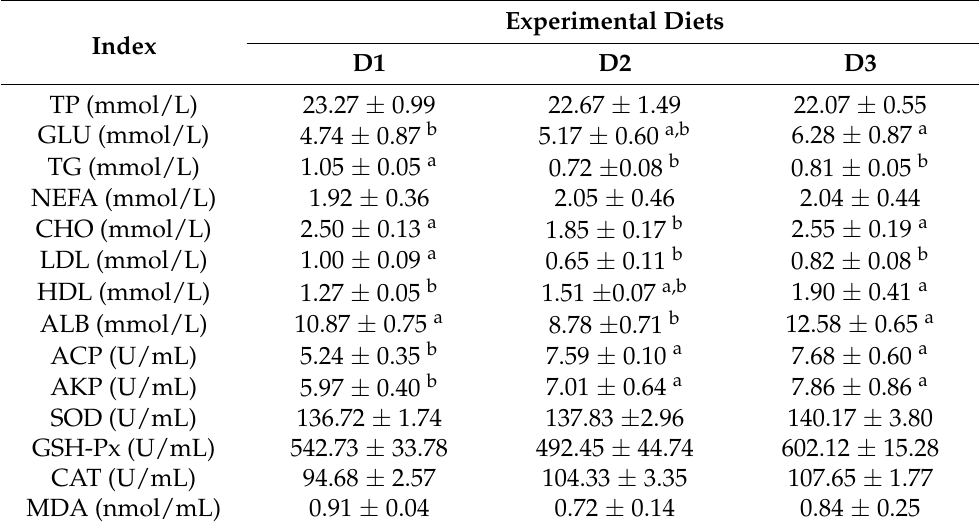
Table 3. Serum biochemical parameters of common carp with different dietary treatments after 8